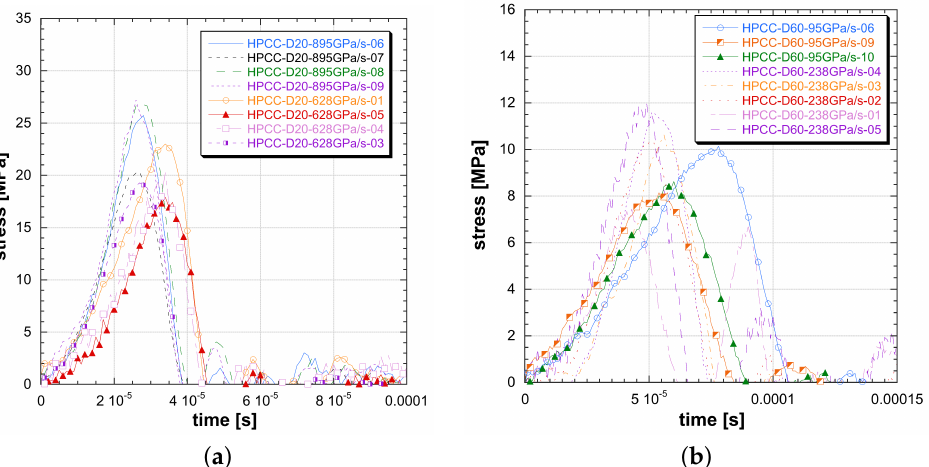
Figure 1. Experimental results tensile stress versus time for the two sizes of ultra-high-performance concretes (UHPCs): ( a ) 20 mm; ( b ) 60